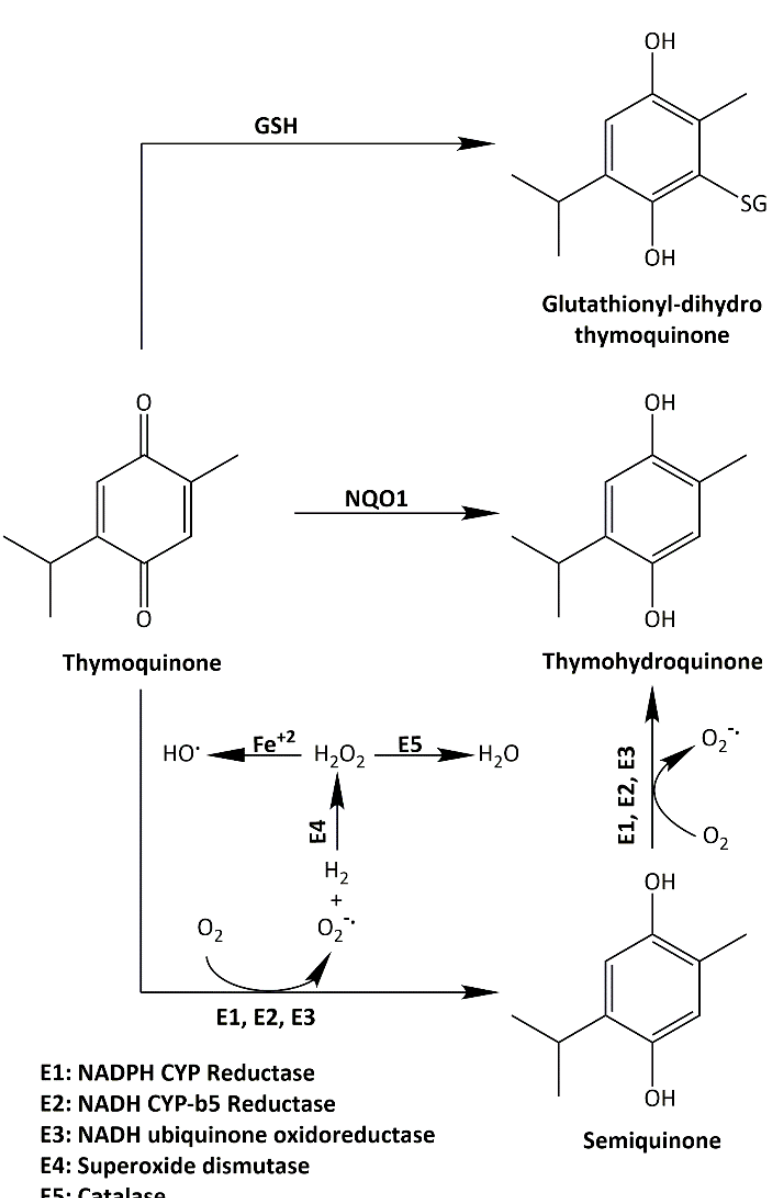
Figure 13. Diagram showing TQ’s oxido-reduction cycling. TQ can be converted through enzymatic reaction into thymohydroquinone either by a one-step two-electron reduction or by